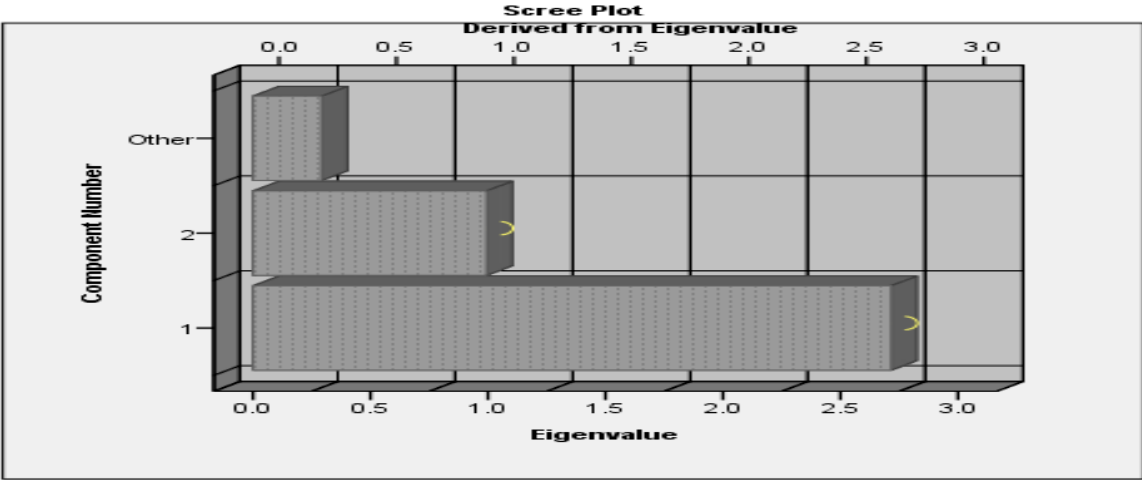
Figure 4. Scree plot of the first sub-factor (F1.1) of sustainable profit in business.